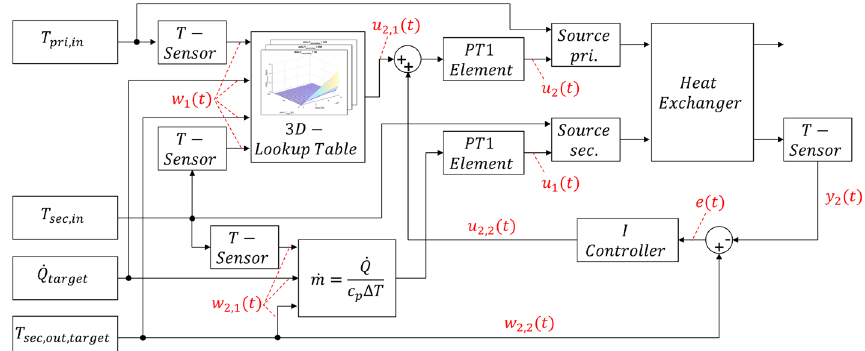
Fig. 7 Model structure of the “CF-based” control concept [own